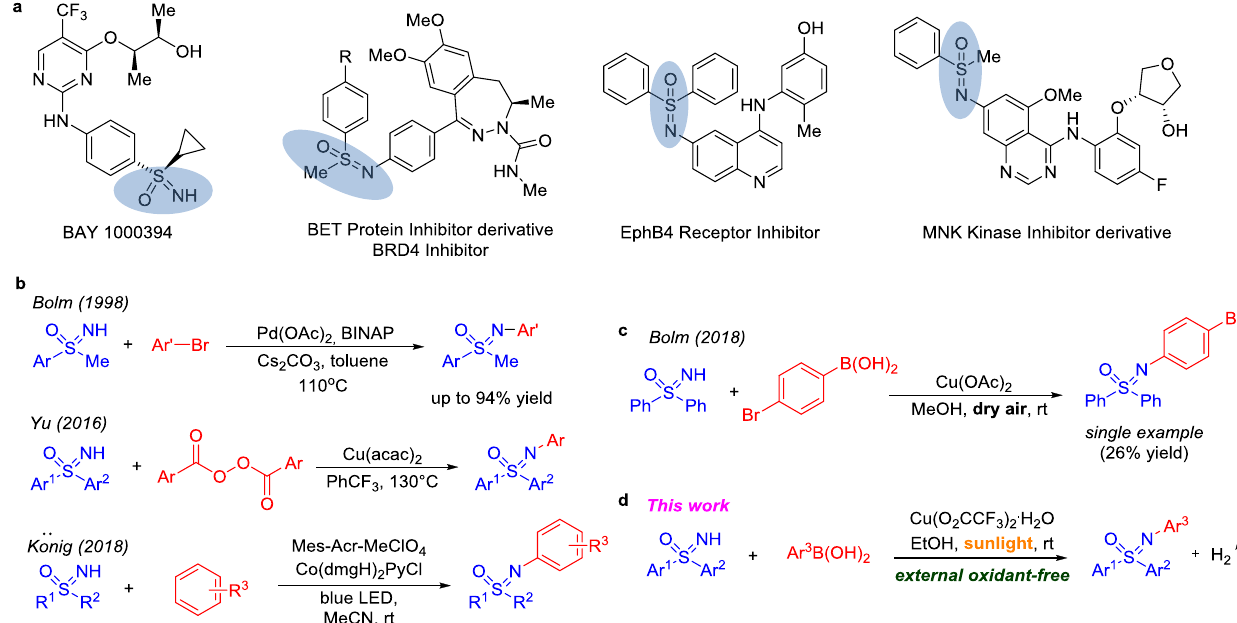
Fig. 1 N -Arylation of sulfoximines. a Representative examples of bioactive sulfoximines. b Three reported strategies to N -aryl sulfoximines. c N -arylation of diaryl sulfoximine via traditional Chan-Lam reaction. d This photoredox Chan-Lam Coupling of free diaryl sulfoximines with arylboronic